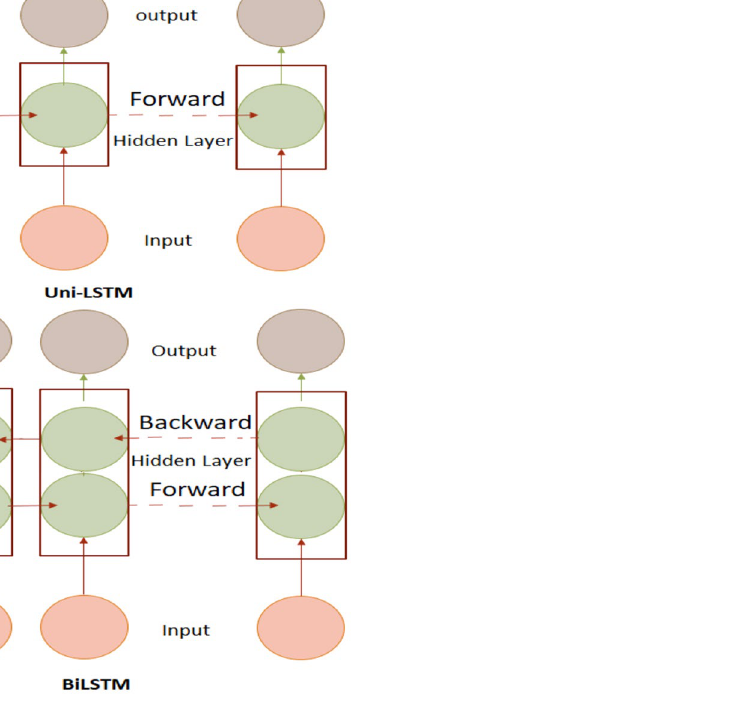
Figure 9. Uni-LSTM/ BiLSTM Architecture 60